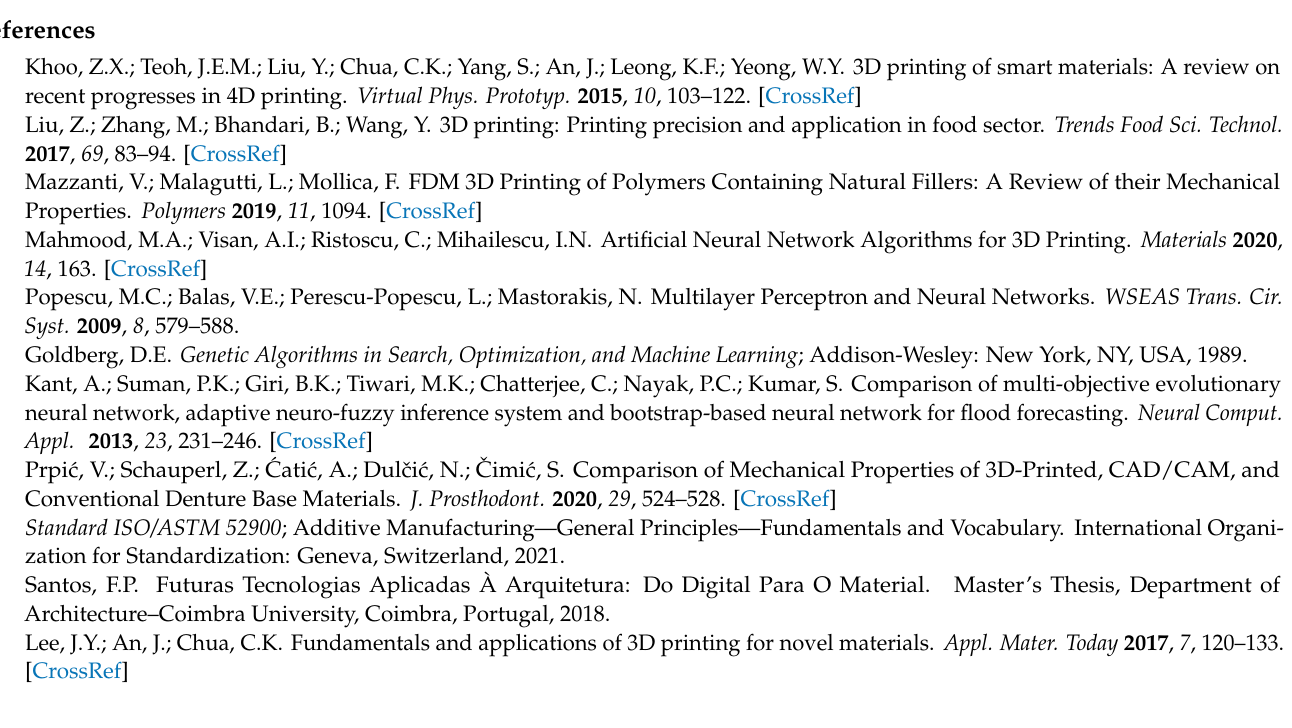
Figure A14. Graphs tensile strength vs. orientation generated from the